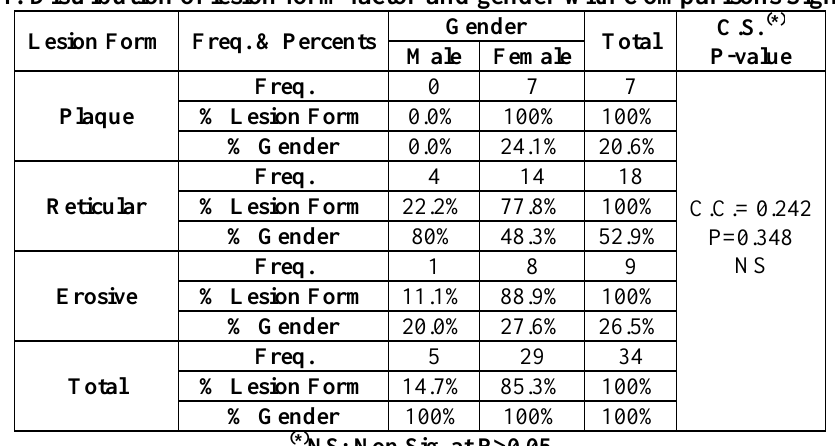
Figure 5: Erosive form of OLP at the right buccal